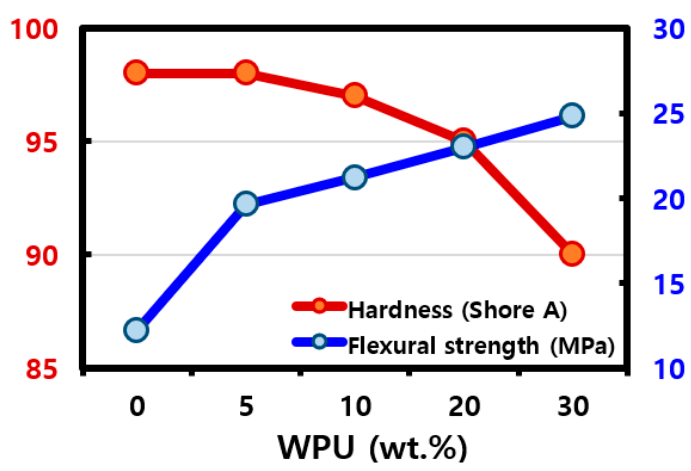
Figure 4. Hardness and flexural strength structures according to WPU contents.